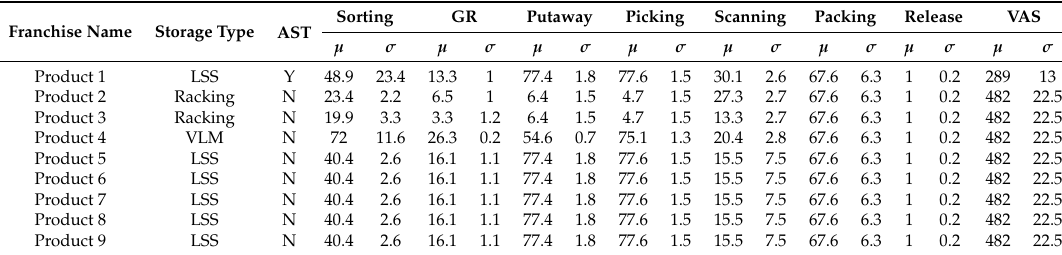
Table 2. Processing times of different franchises and processes. GR represents goods receipt; VAS value added